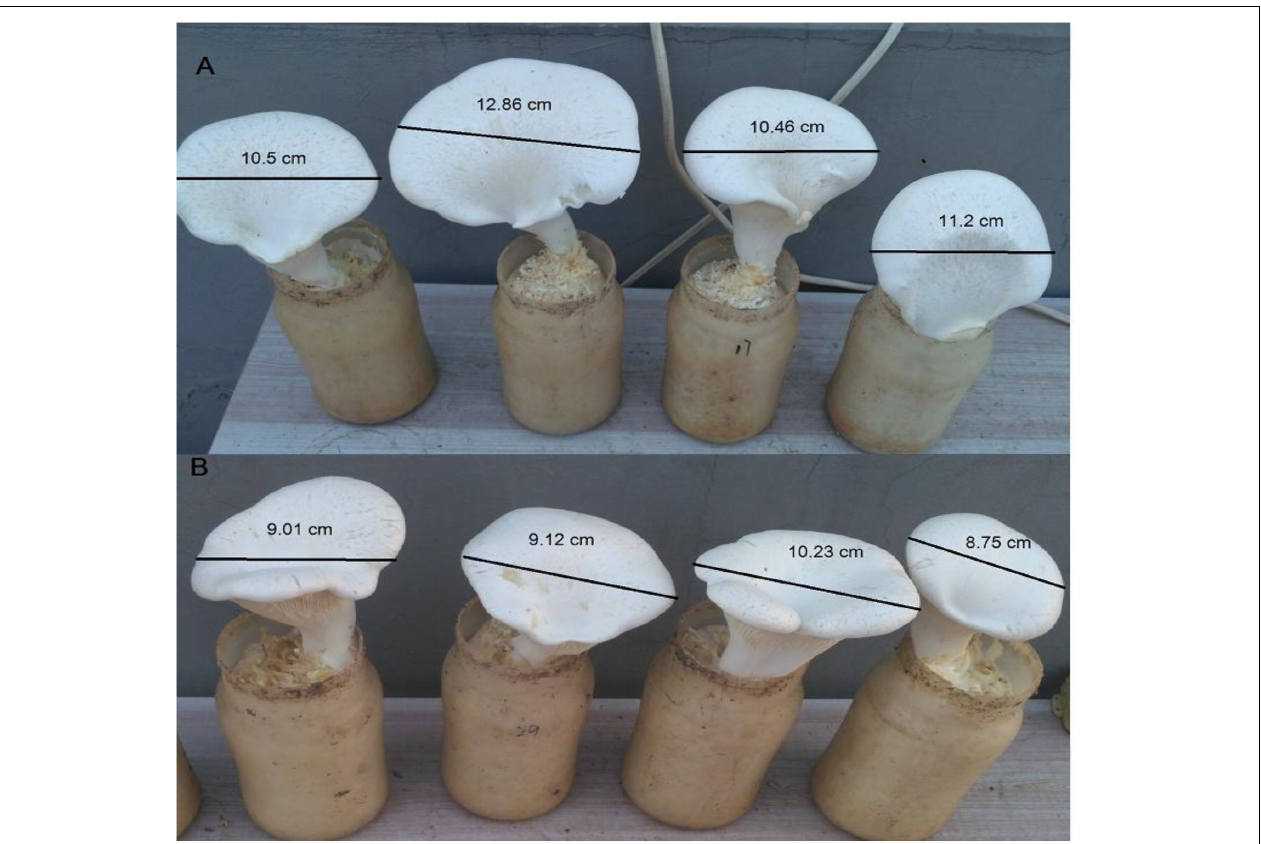
FIGURE 1 | The diameter of fruiting body after a MPMP of 35 days at 17 ◦ C (A) and 29 ◦ C (B) , separately.